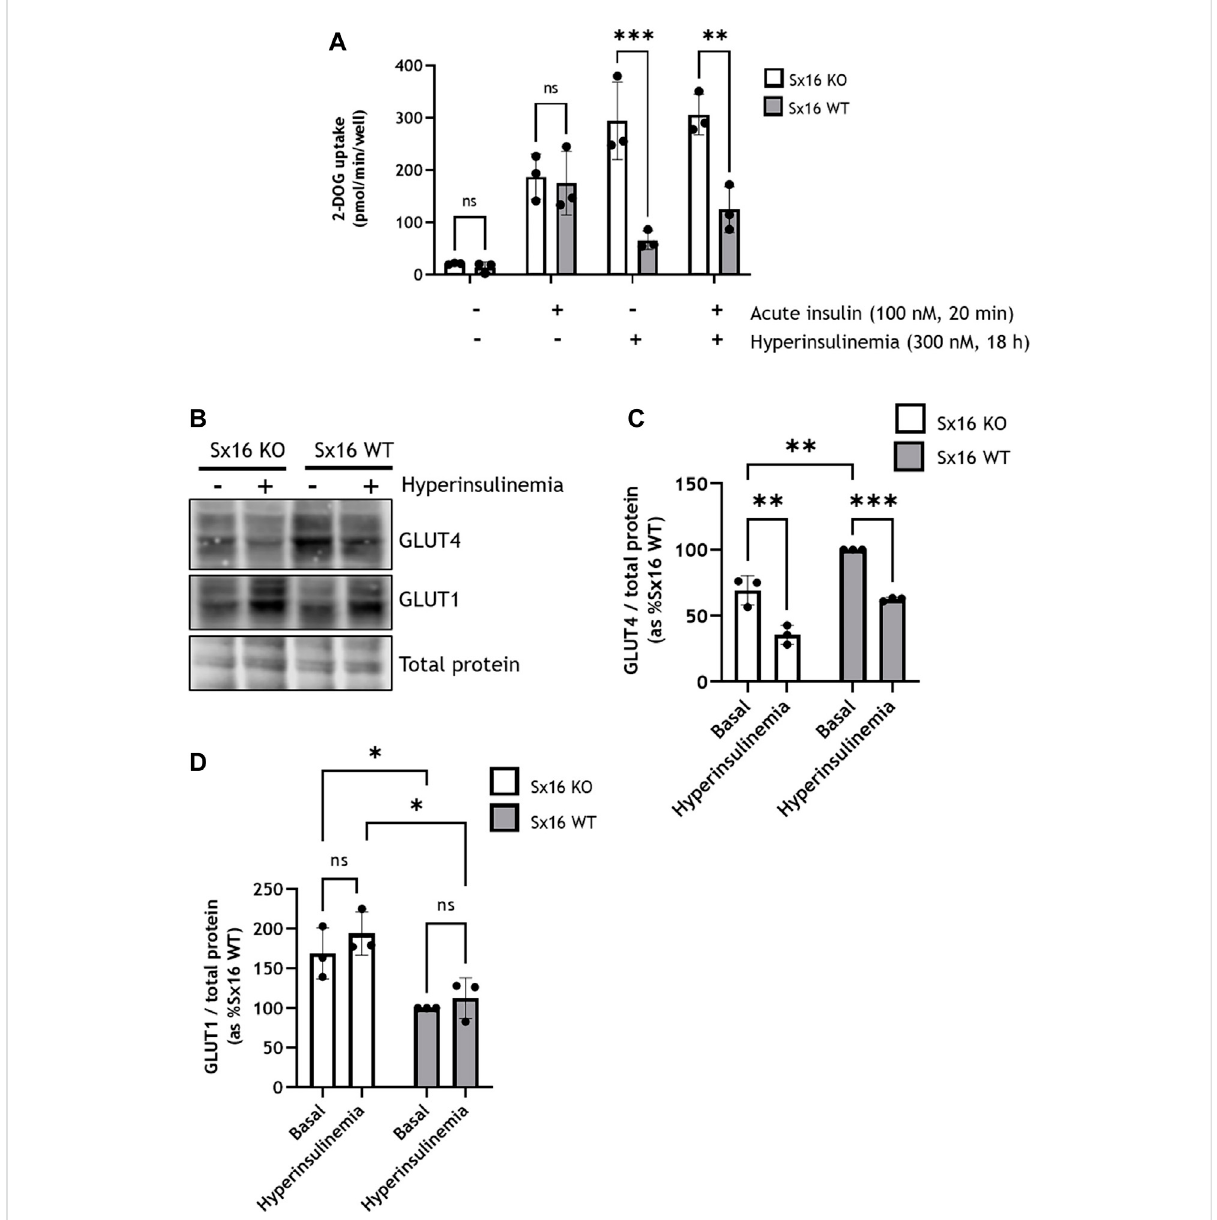
Sx16 knockout adipocytes have an altered response to hyperinsulinemia. 3T3-L1 adipocytes were incubated with 300 nM insulin for 18 h to induce insulin resistance ( ‘ hyperinsuinemia ’ ) of left untreated (control) (A) Glucose uptake was measured by the accumulation of 2-[ 3 H] deoxyglucose.Intheseexperimentscellswereincubatedwithoutinsulinoracutelychallengedwithinsulin,asshown,priortoassayofdeoxyglucose uptake.Eachdatapointonpanel Carethemeansofthreebiologicalreplicates (B) Lysatesfromcellsundertheseconditionswerepreparedand immunoblotted for GLUT4 and GLUT1 (C – D) Quanti fi cation of GLUT4 (C) or GLUT1 (D) was determined by comparison with total protein using densitometric analysis. Data shown represent the mean ± SD of three independent experiments. * p < 0.05, ** p < 0.01, *** p < 0.001 by two-way ANOVA; n.s. = not signi fi